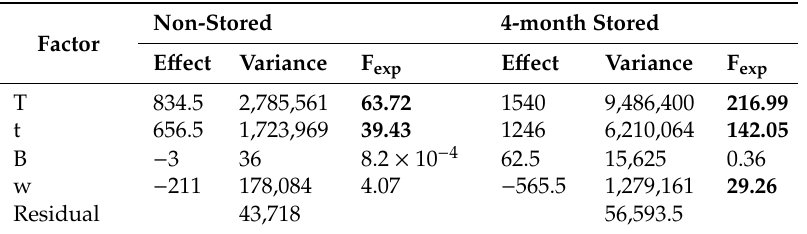
Table 2. Analysis of variance of the results obtained from the fractional factorial design, showing the factors significantly a ff ecting acrylamide